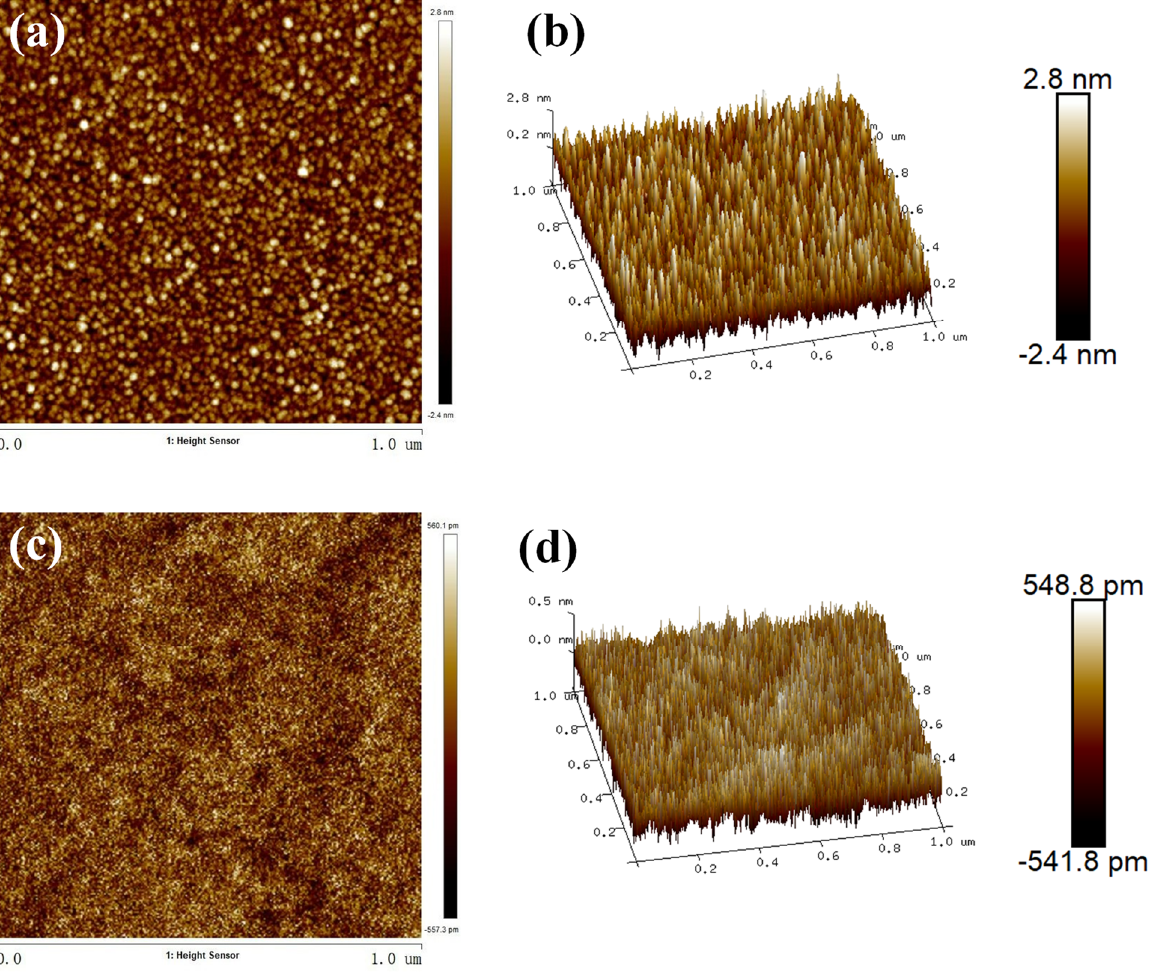
Figure 10. AFM images of SiO 2 thin films under initial conditions ( a , b ), and optimized conditions ( c , d ). Table 3. Surface roughness (in nm) of SiO 2 films prepared under various